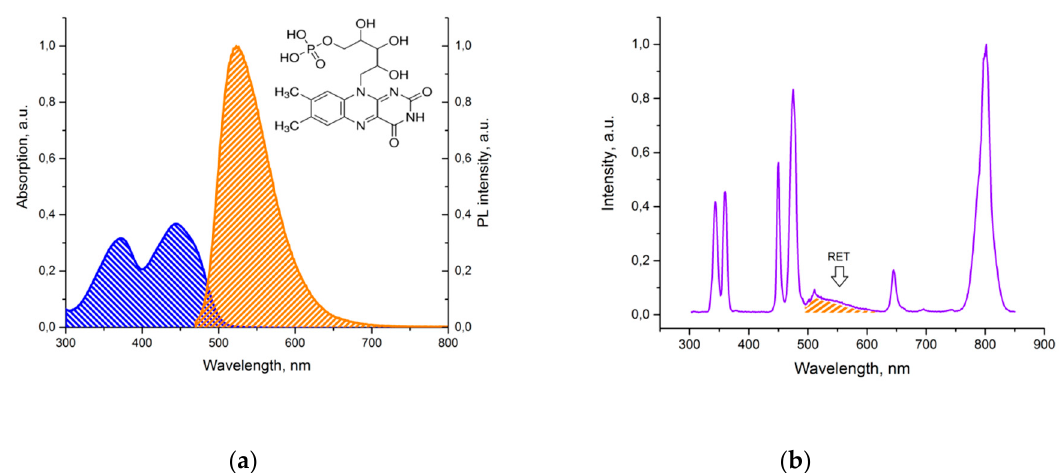
Figure 5. ( a ) The excitation (blue) and emission (orange) spectra of flavin mononucleotides (FMN),